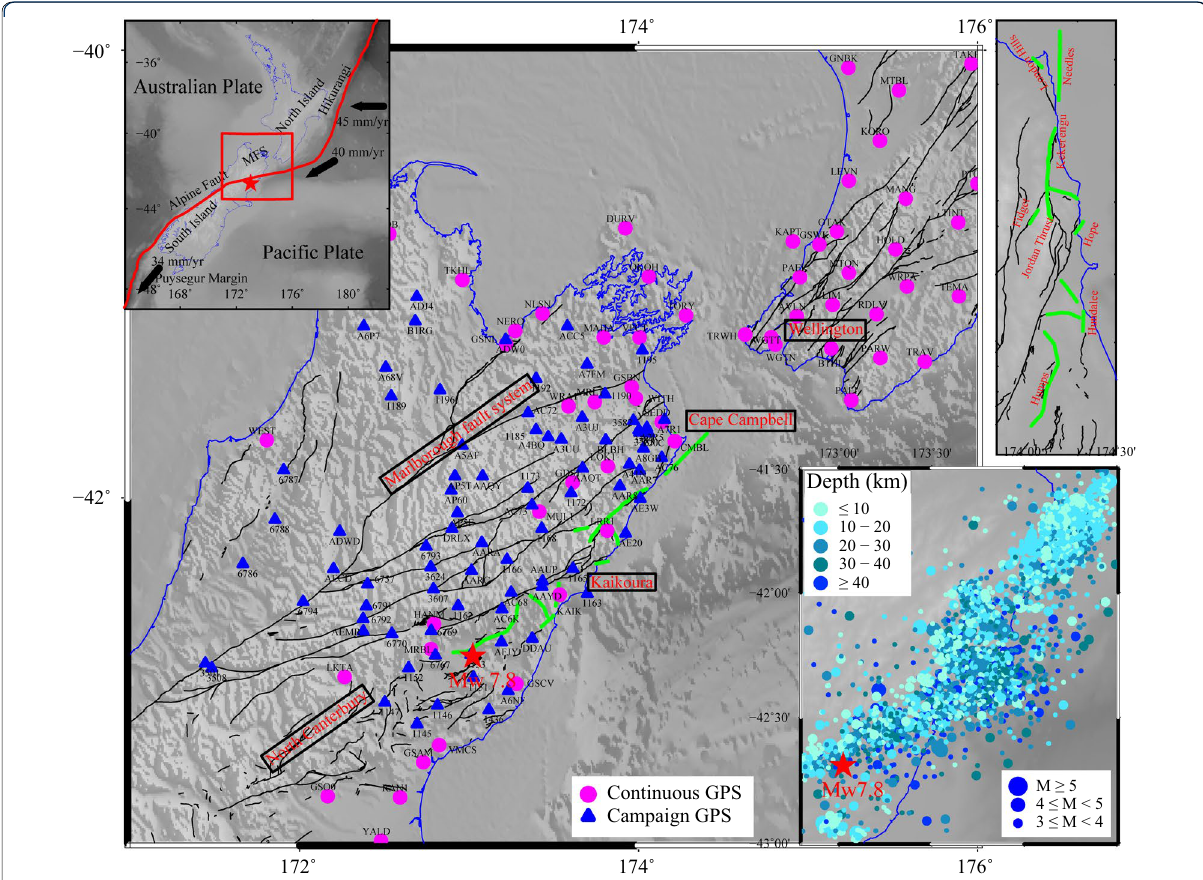
Fig. 1 Tectonic context of the 2016 Mw 7.8 Kaikoura earthquake. The green lines indicate surface ruptures formed during the earthquake, which are also displayed in the top right inset. The red star represents the epicenter of the Kaikoura earthquake. The magenta circles and blue triangles are the continuous and campaign GPS sites, respectively. The illustration in the upper left represents the tectonic setting of New Zealand, located between the Australian and Pacific plates. The red square indicates the study area. The inset in the bottom right shows the distribution of after- shocks ( M > 3, from the GeoNet earthquake catalogue) occurring after the